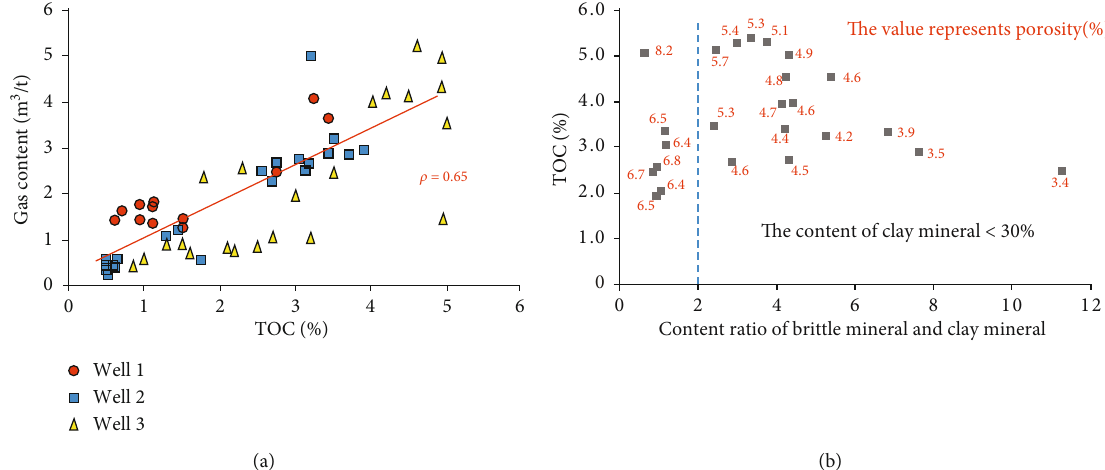
Figure 9: Correlation of reservoir matrix parameters in the Fuling shale gas fi eld. (a) The positive correlation between TOC and gas saturation. (b) The correlation between mineral components and TOC. The map shows that TOC increases with the augment of brittle mineral content, and the porosity is also positively correlated with TOC because of the contribution of organic